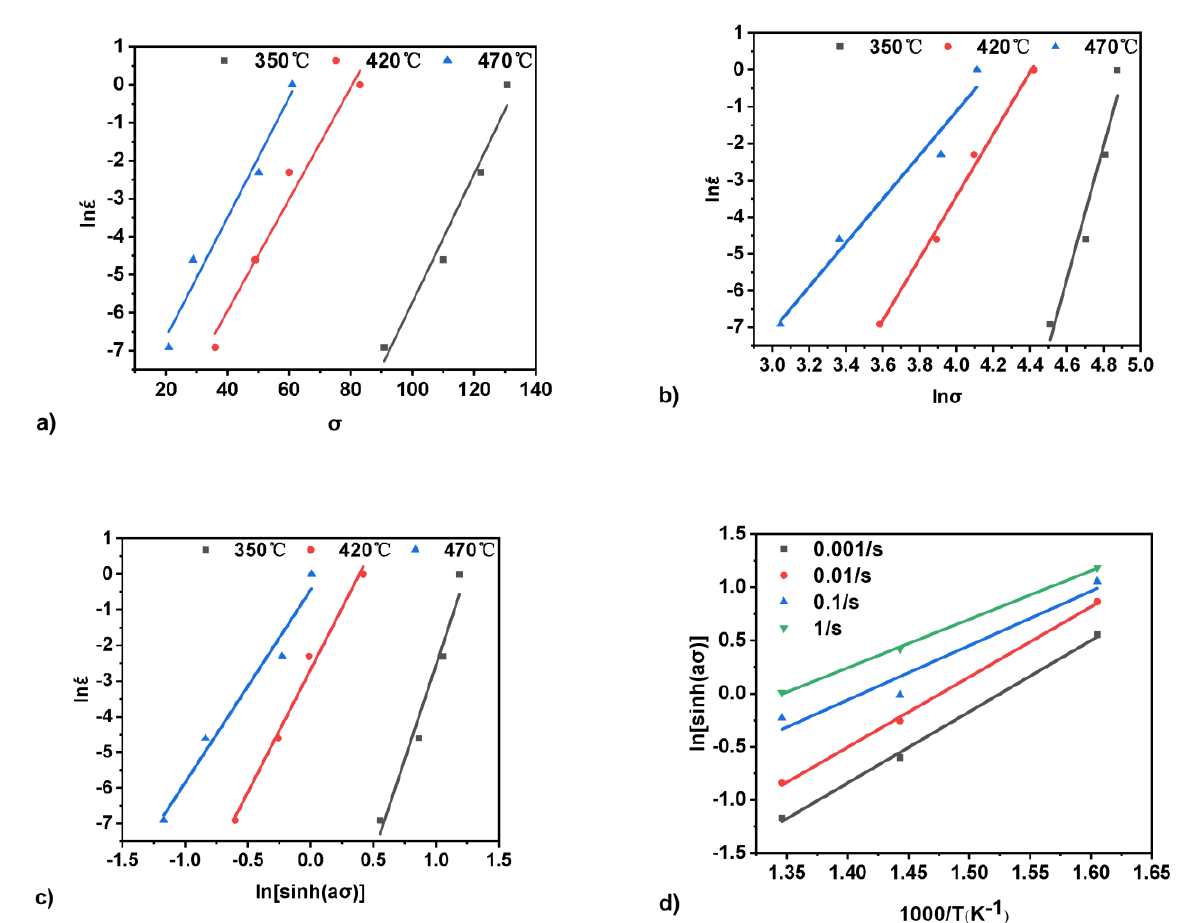
Figure 3. Graphical solutions for the Zener − Hollomon model: ( a ) the parameter n1 is the slope in the graph ln ε̇ v. σ ; ( b ) the parameter β is the slope in the graph ln ε̇ v. ln σ ; ( c ) the parameter n2 is the slope in the graph ln ε̇ v. ln[sinh( ασ )]; ( d ) the second term in Equation (3) is the slope in the graph ln[sinh( ασ )] v. 1000/T.